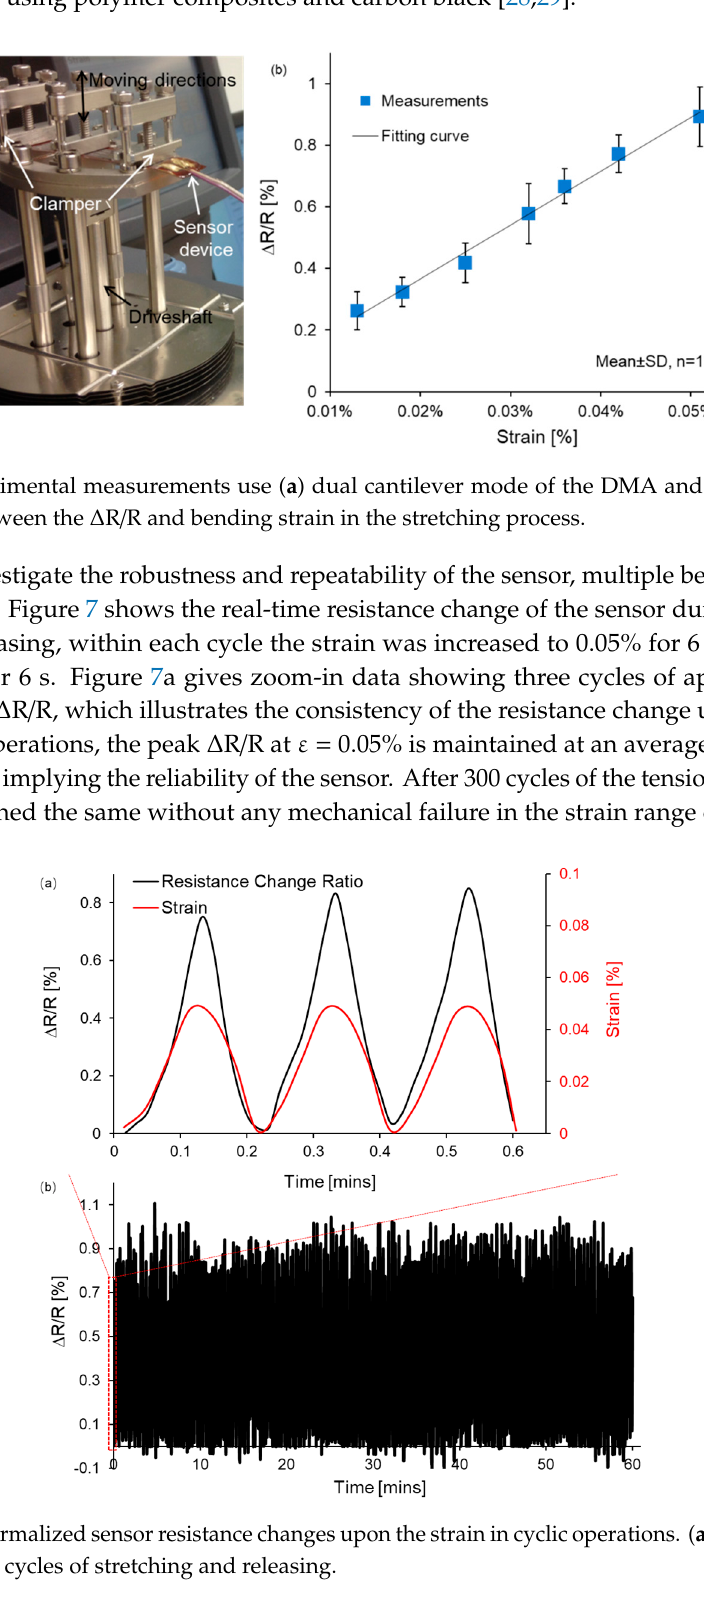
Figure 5. Resistance response to various displacement values when the sensor is bent.